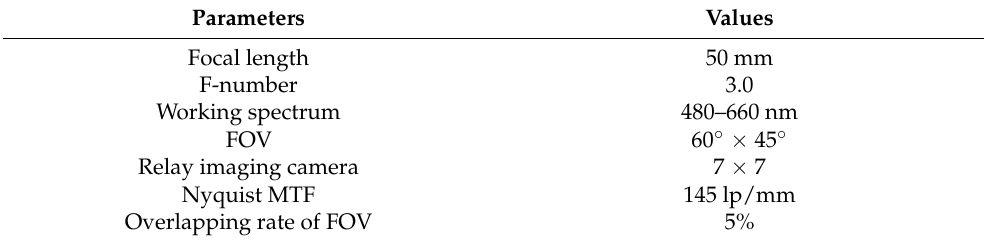
Table 1. Design specifications of the concentric multi-scale optical system.